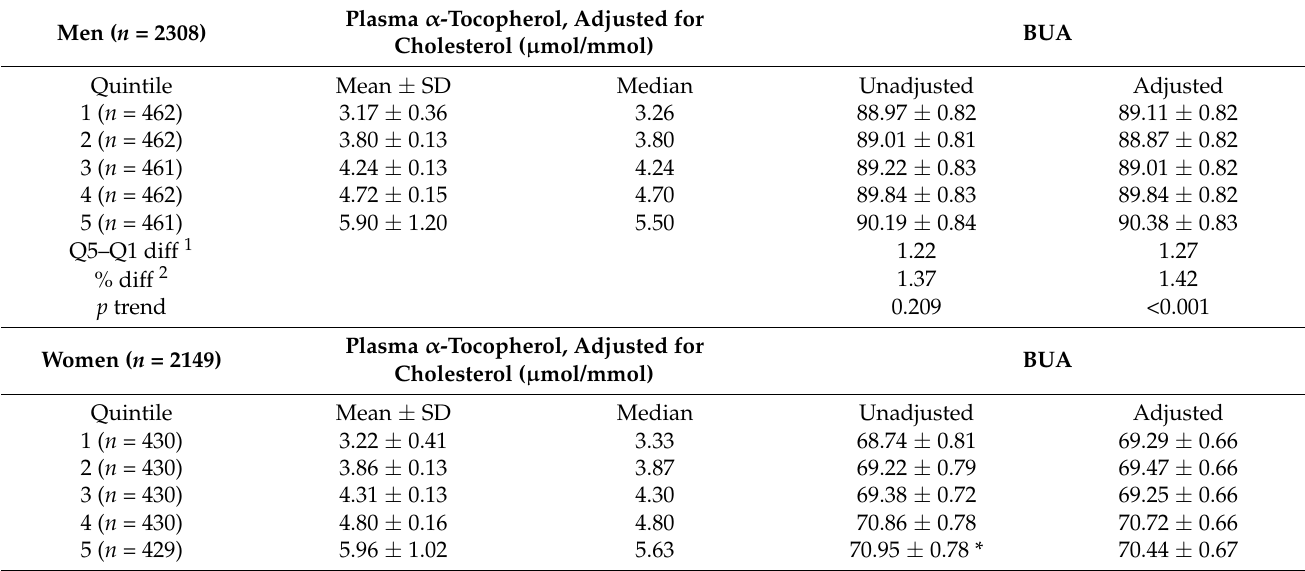
Table 6. Multivariate adjusted calcaneal BUA for EPIC-Norfolk participants, stratified by sex and quintiles of plasma α -tocopherol, plasma γ -tocopherol and α -tocopherol: γ -tocopherol ratio, adjusted for by blood cholesterol